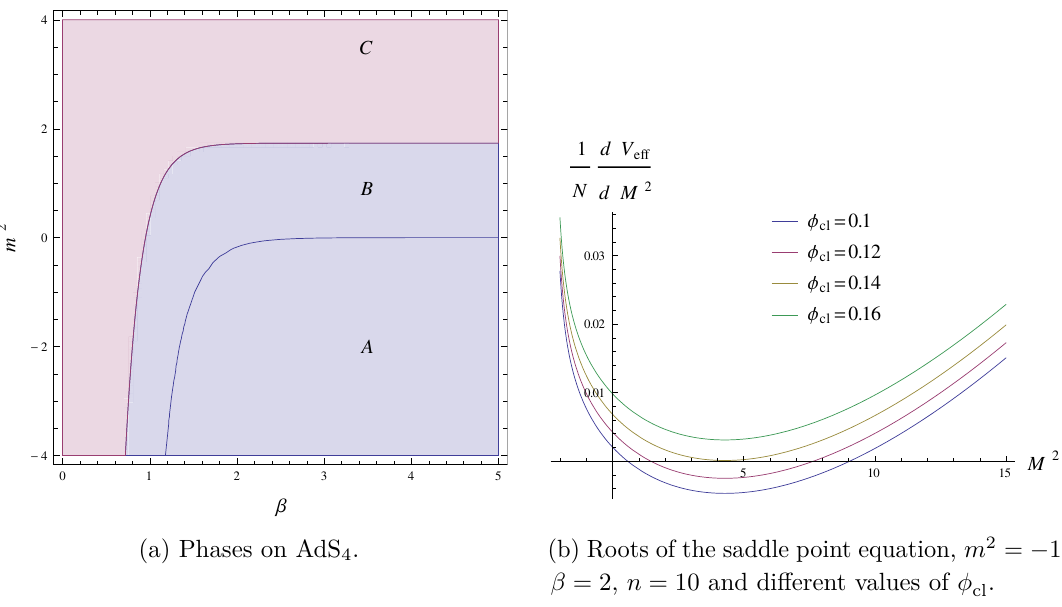
Figure 10. Phases and roots of saddle point equation for AdS 4